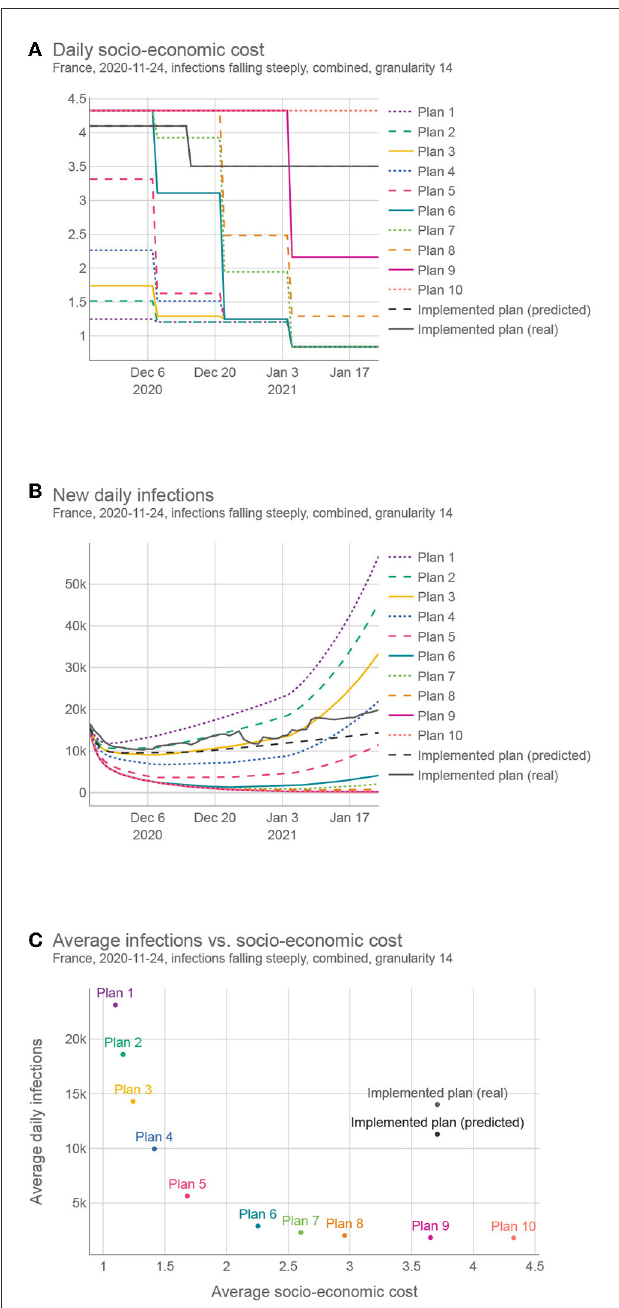
FIGURE6 Comparing different intervention plans for France. (A) Shows the SEC (GDP loss + social cost) over time. (B) Shows the predicted number of infections, (C) Shows the trade-offs between the two criteria (SEC and the number of infections) for different